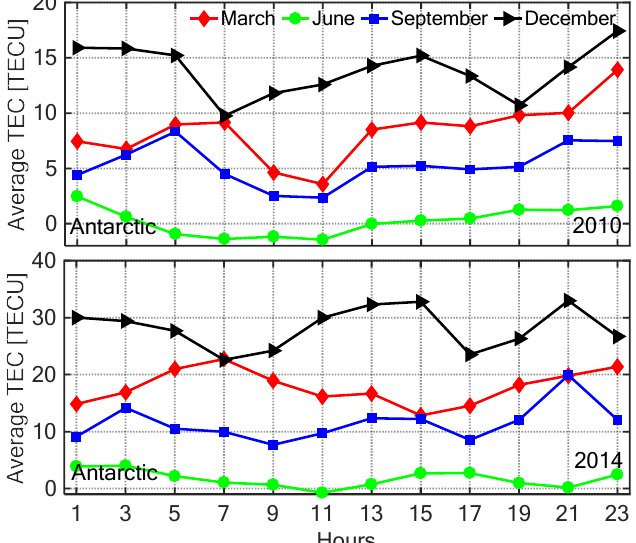
Figure 15. The time series of the C0,0 coefficient with 2 h resolution in March, June, September, and December under low ( top ) and high ( bottom ) solar activity year in the Antarctic.